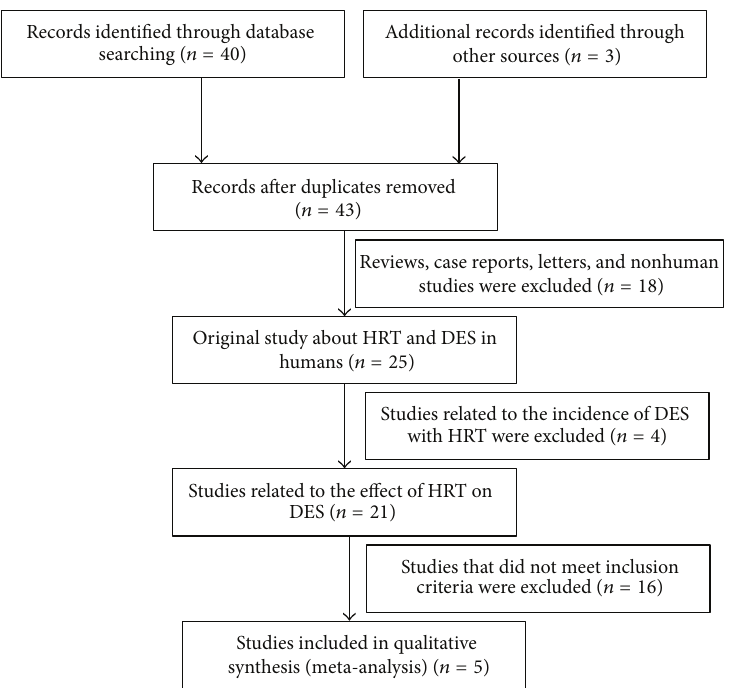
Figure 1: Flow diagram of the study identification, eligibility, and inclusion